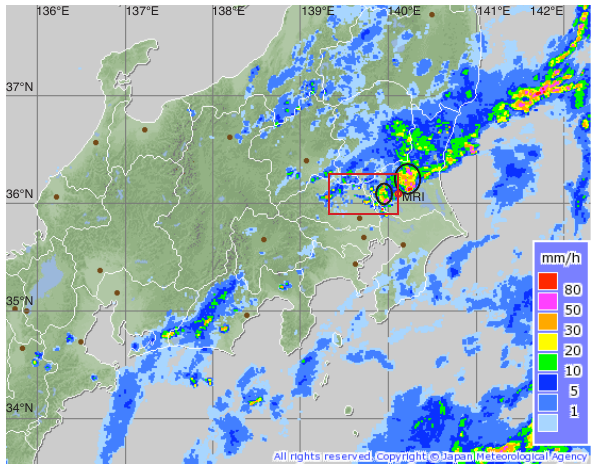
Fig. 6. Horizontal distributions of the rainfall rate at 04:00JST on 7 July 2010 obtained from operational radar observations with the Figure 6. Horizontal distributions of the rainfall rate at 04:00 JST on 7 July 2010 obtained from operational color scale on the bottom right. A rectangle depicts the analytical radar observations with the color scale on the bottom right. A rectangle depicts the analytical area in Fig. 7, area in Fig. 7, and the red open circle on the right edge of the rect- and the red open circle on the right edge of the rectangle indicates the location of the MRI. Two black ovals angle indicates the location of the MRI. Two black ovals surround surround heavy convective regions. heavy convective regions.